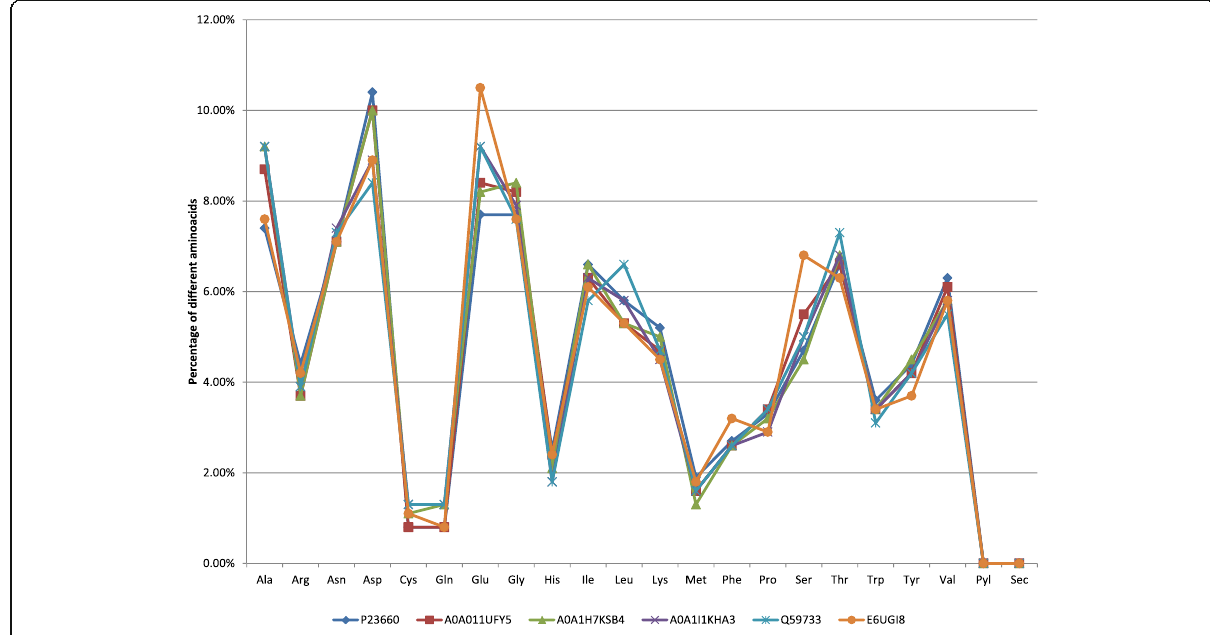
Fig. 2 Graphical representation of the amino acid composition of selected cellulase sequences